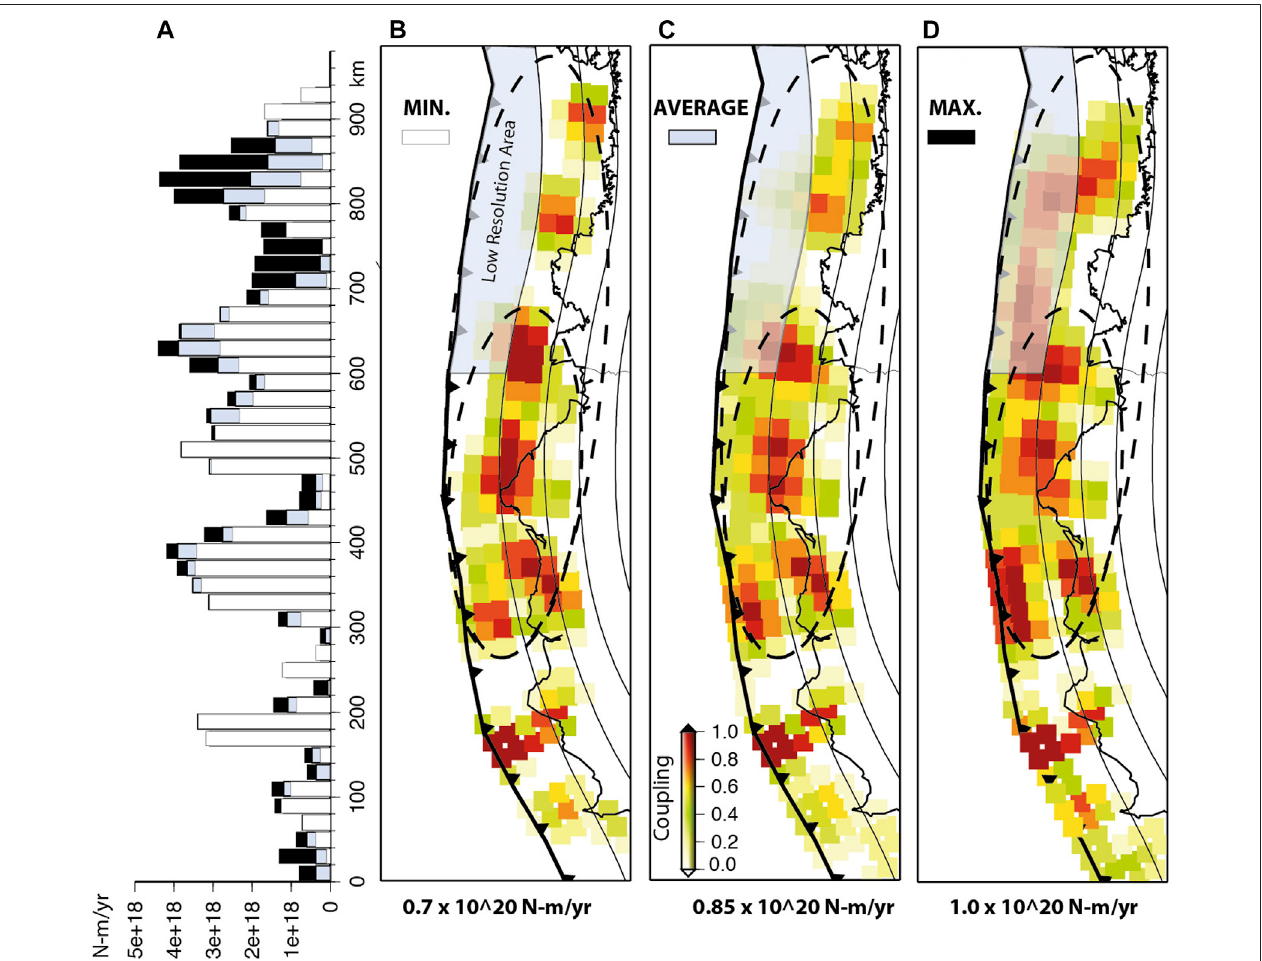
FIGURE4| Range ofthebest GPS- fi ttinginterseismic coupling models withtheir associated along-trenchmoment de fi cit rate. (A) Alongtrench strike variationsof the moment de fi cit rate (in Nm/yr) as determined from the minimum ( (B) , in white, 0.7 × 10 20 N-m/yr), average ( (C) , in gray, 0.85 × 10 20 N-m/yr), and maximum ( (D) in black, 1.0 × 10 20 N-m/yr) interseismic coupling models. Each bar represents the cumulative moment de fi cit rate calculated within 20 km-large sections normal to the trench axis. (B – D) shows the minimum, the average, and the maximum interseismic coupling models, respectively, with the fully locked asperities (in red) and the fully creeping segments in white. Overall, the interseismic coupling remains con fi ned within the fi rst 50 km depth of the slab interface with some robust characteristics thatremainstableinallmodels(i.e.,largeasperitieslocationandcreepingsegments)andsigni fi cantvariationsinareasoflowspatialresolution(shadedgrayrectangle)as deduced from the checkerboard tests shown in Supplementary Figures S3A,B